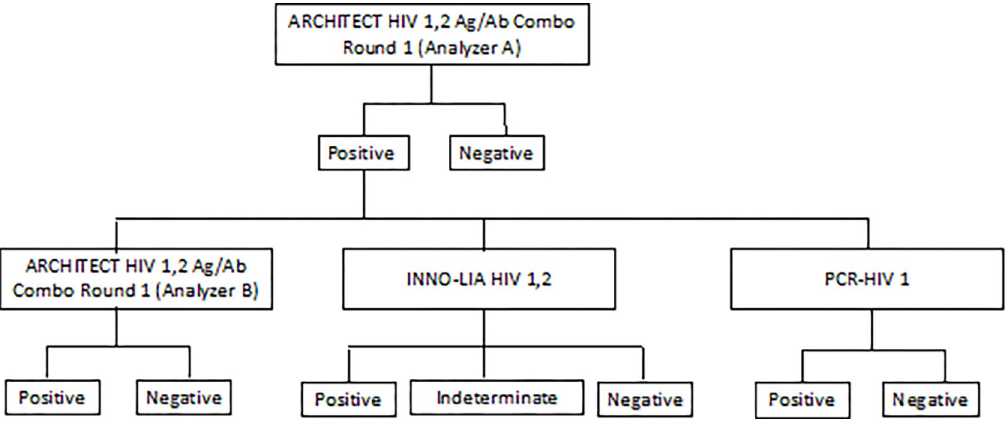
Fig 1. A chart summary of HIV diagnosis workflow. Analyzer B, INNO-LIA ™ HIVI/II and PCR-HIV1 tests were done on a freshly drawn